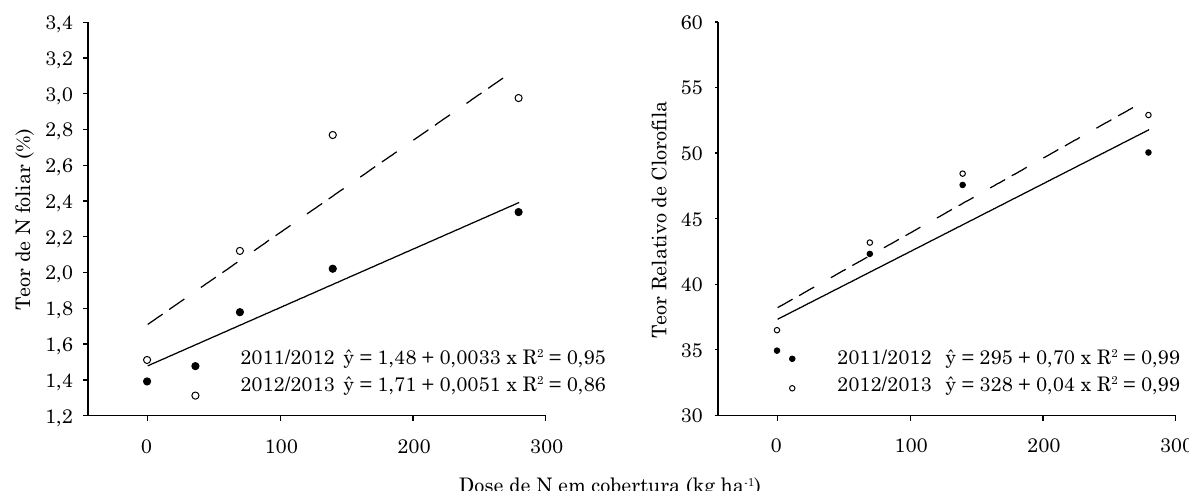
Figura 2. Teor de N foliar e Teor Relativo de Clorofila (TRC) na folha-índice do milho em função da aplicação de quatro doses e quatro fontes de N em cobertura - 2011/12 e